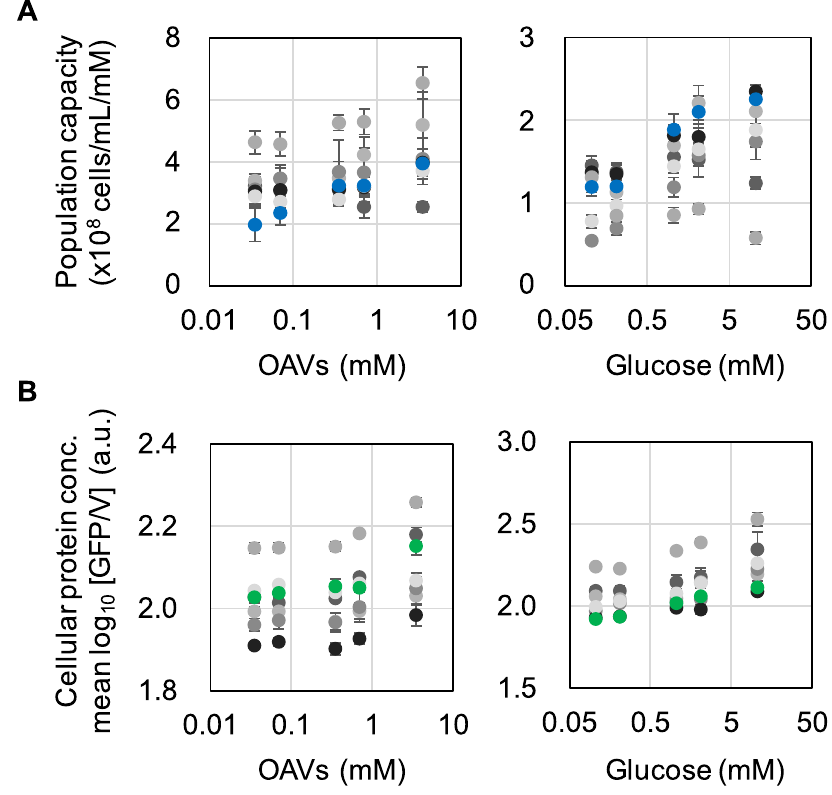
Fig. 5 Carbon utilization capacity and cellular protein abundance. A Carrying capacity. The maximal population size (cells/mL) per unit (mM) carbon source (OAVs or glucose) is shown. The Ori and Evos (evolved in OAVs) are indicated as blue and colourless circles, respectively. The grey circles (gradation from light to dark grey) indicate the six lineages. Standard errors of biological replications ( N > 5) are indicated. B Cellular protein abundance. The cellular protein concentration is represented by GFP/V on the logarithmic scale. The Ori and Evos (evolved in OAVs) are indicated as green and colourless circles, respectively. The gradation from light to dark grey indicates the six lineages. Standard errors of biological repeats ( N > 5) are indicated.